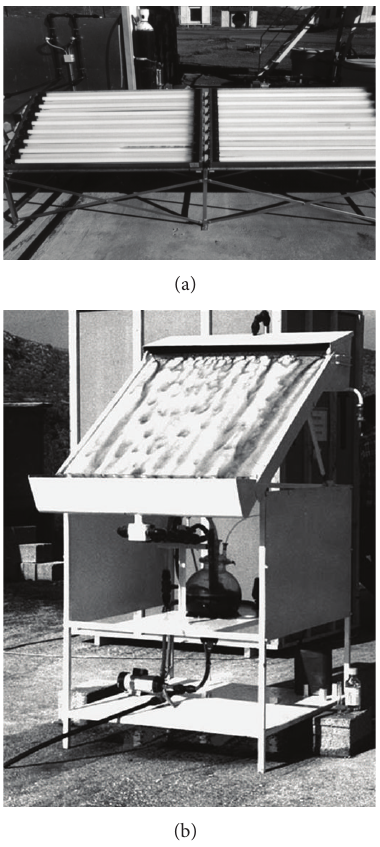
Figure 10: (a) Two compound parabolic collectors (CPCs) of one prototype module, (b) falling film reactor (FFR). (Figure 10(a) is reproduced from reference [30]. Copyright 1999, with permission from Elsevier; Figure 10(b) is reproduced from reference [31]. Copyright 2004, with permission from